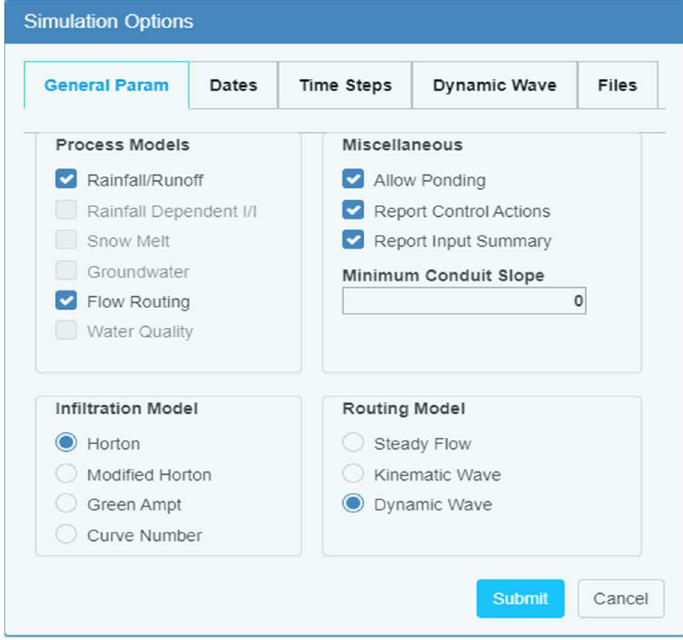
Figure 13. Parameter settings.